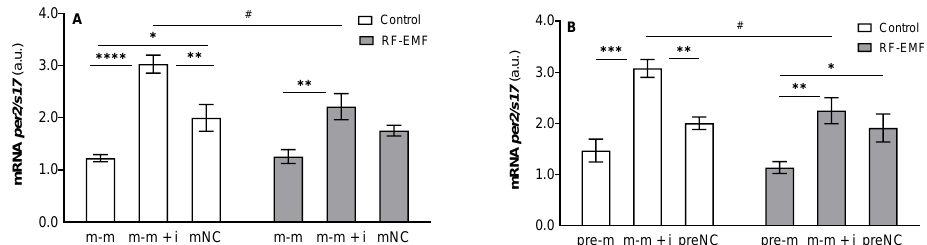
Figure 4. Effect of miR-34a administration on per2 mRNA expression in DLD1 cells cultured in Wi-Fi-free conditions (white columns) or exposed to 24h lasting RF-EMF exposure (grey columns). Cells were transfected with ( A ) miR-34a-5p (m-m), ( B ) pre-miR-34a (pre-m), mimic of mature miR-34a together with the miR-34a inhibitor (m-m + i) or corresponding negative control of mature and pre-miRNA (mNC and preNC, respectively). The data were relativised to the corresponding negative control measured under control conditions and presented as the mean ± SEM (n = 4). a.u.—arbitrary units. Two-way ANOVA, Tukey’s post hoc test, * p < 0.05, ** p < 0.01, *** p < 0.001, **** p < 0.0001— comparison between groups transfected with different oligos within the control or RF-EMF treatment. Two-way ANOVA, Š í d á k’s multiple comparisons test, # p < 0.05 comparison between the control and RF-EMF groups.